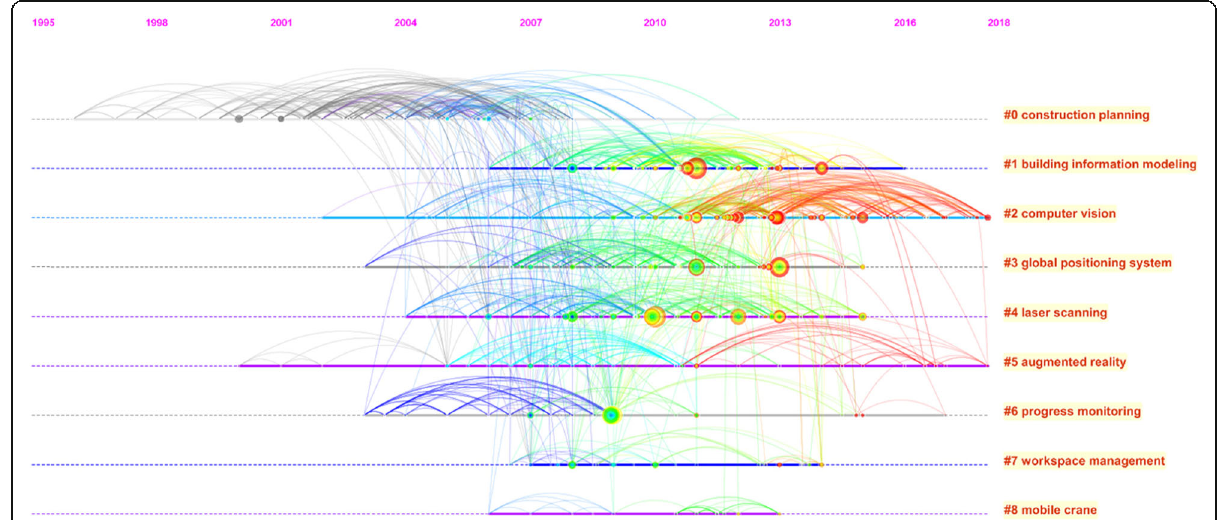
Fig. 4 The landscape timeline view of the co-citation network